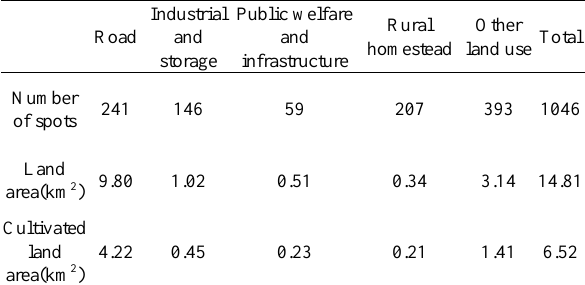
Table 3. Verification of illegal land